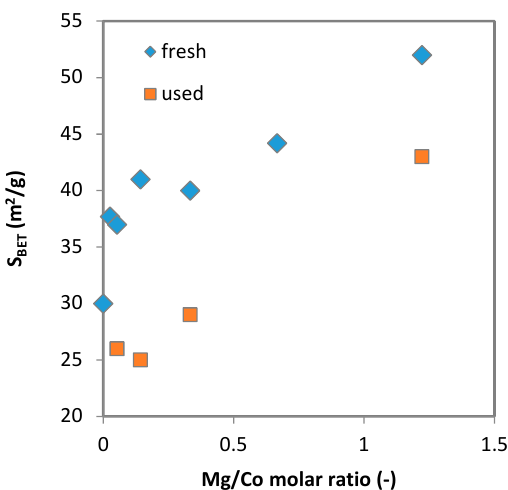
Figure 2. Dependence of S BET on Mg / Co molar ratio for 2K / Mg i catalysts before and after reaction of NO decomposition.